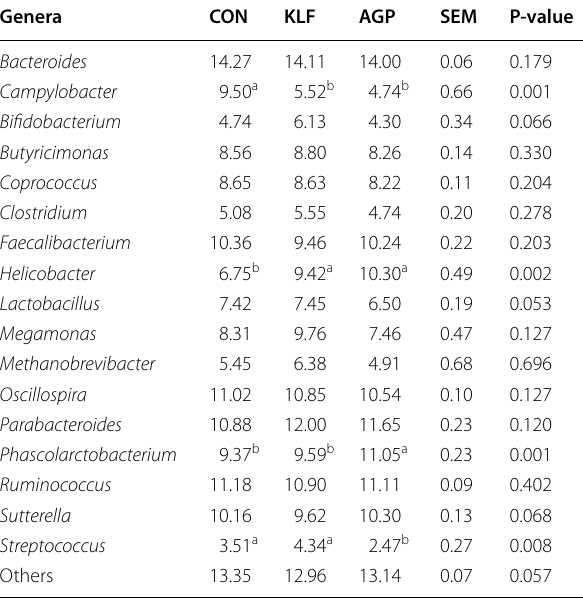
Sequences relative abundances were transformed using log2 SEM standard error of the mean; CON control treatment; KLF kudzu-leaf flavonoids supplement treatment; AGP the antibiotic supplement (Aureomycin) treatments a,b Within rows and with different letters differed significantly (P <